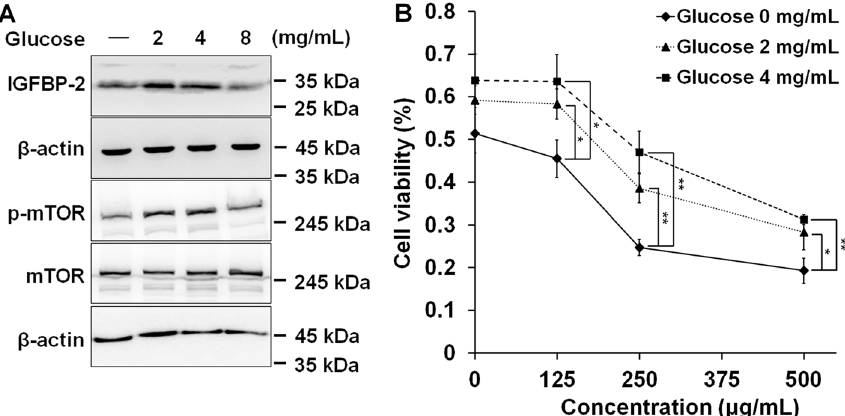
Figure 4. IGFBP-2 can prevent AOFE-induced apoptosis. ( A ) FaDu cells were cultured in a media containing the indicated concentration of glucose for 24 h. The cell lysates were prepared, and analyzed by western blot analysis using anti-IGFBP-2, anti-phosphor mTOR, anti-mTOR and β-actin antibodies. ( B ) After FaDu cells were pretreated with the indicated concentration of glucose for 24 h, AOFE was treated at various concentration. Cell viability was analyzed by MTT assay. The data are presented as the mean ± SD. Statistical analyses were performed using paired t-test. * p < 0.05, ** p < 0.01.